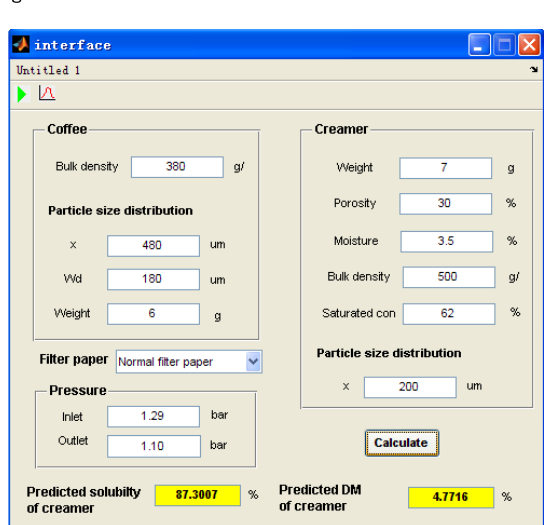
Fig. 4. Structure of the model.